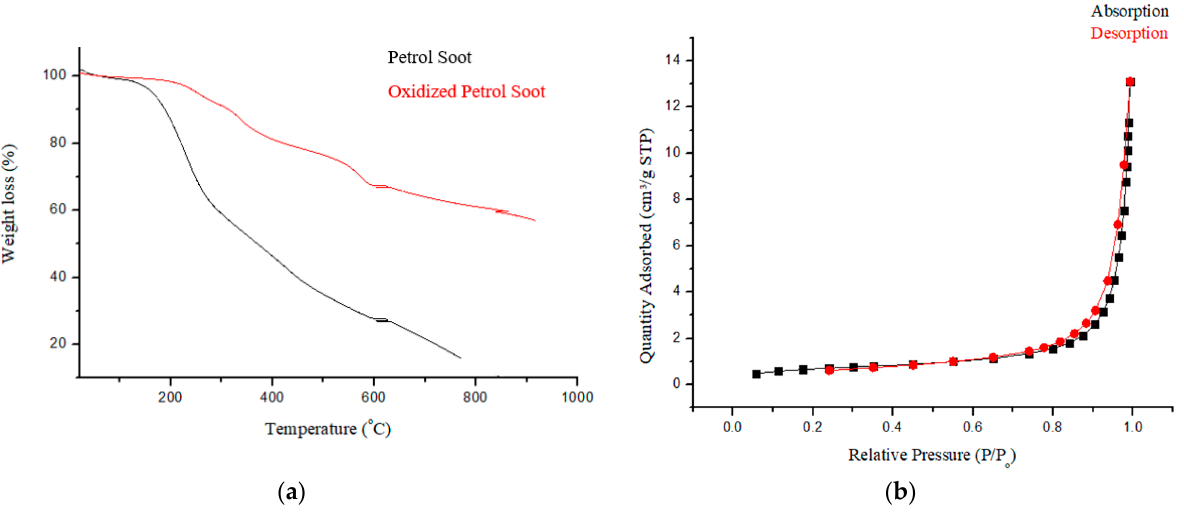
Figure 3. ( a ) Thermogram and ( b ) N 2 adsorption isotherm of PSN showing type III